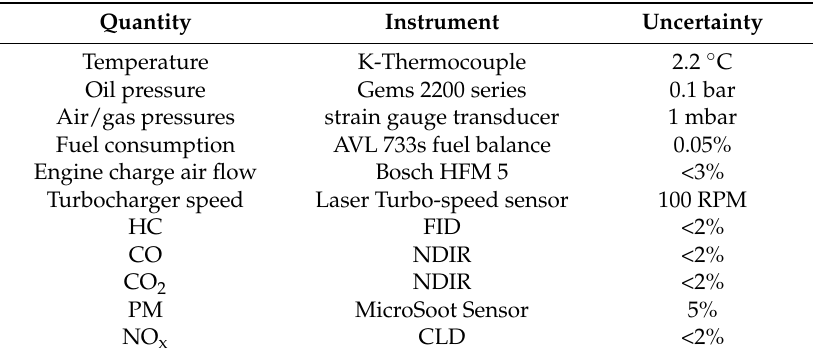
Table 1. Instruments